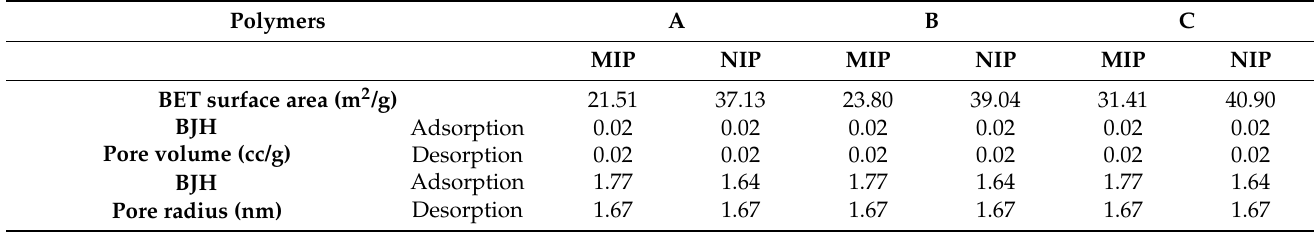
Table 2. Surface area, pore volume and pore size of synthesized polymers using BET and BJH methods. Polymers